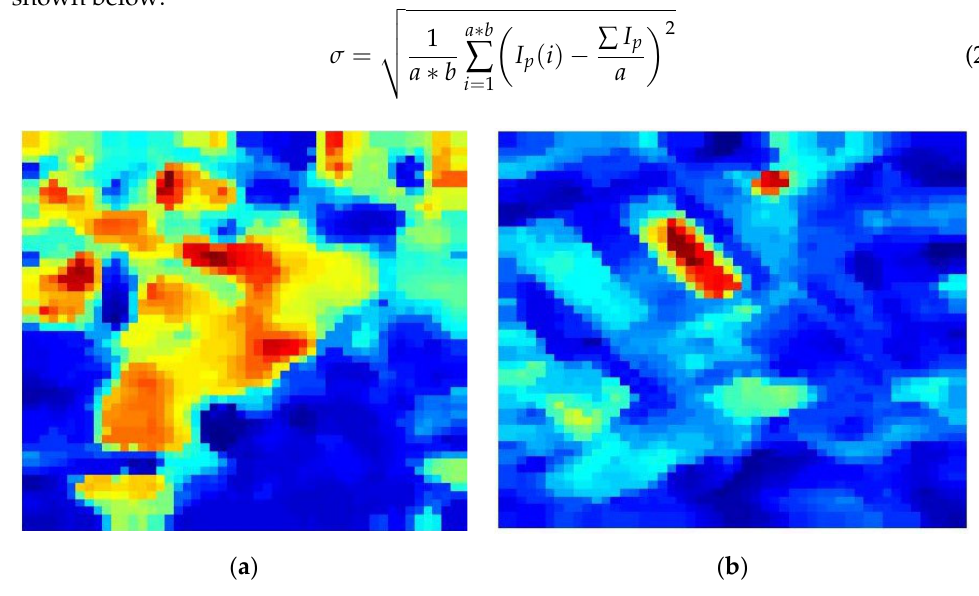
Figure 4. Filtered images of: ( a ) Indian Pines and ( b ) Pavia University. Here, a is the row size and b is the column size of the images. To obtain a good quality image (as Figure 5) the subsequent processing:pixel values of the actual input image are normalized with the maximal mean values from the enhanced image.